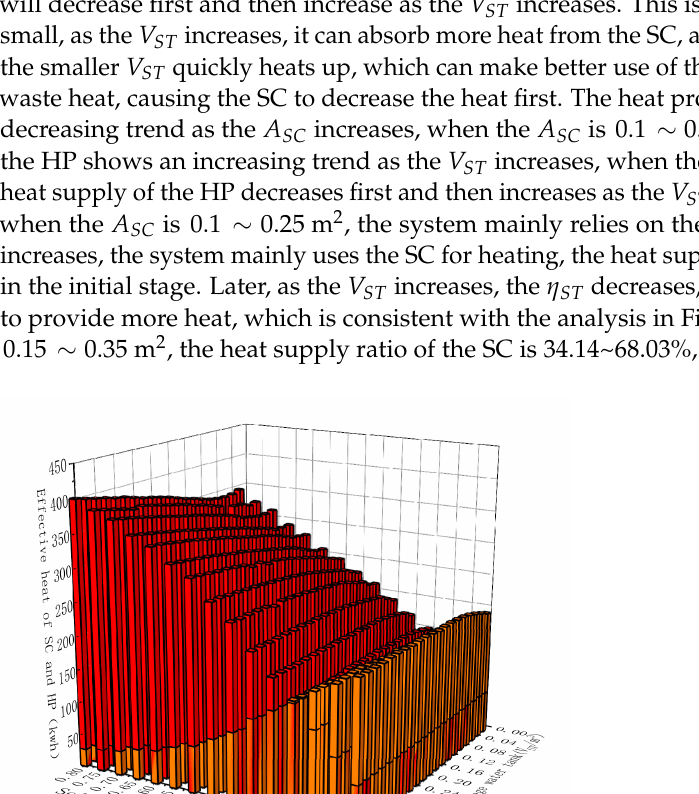
Table 5. The following analysis in this paper will be based on Nanjing, with a A SC of 0.3 m 2 and a V ST of 0.04 m 3